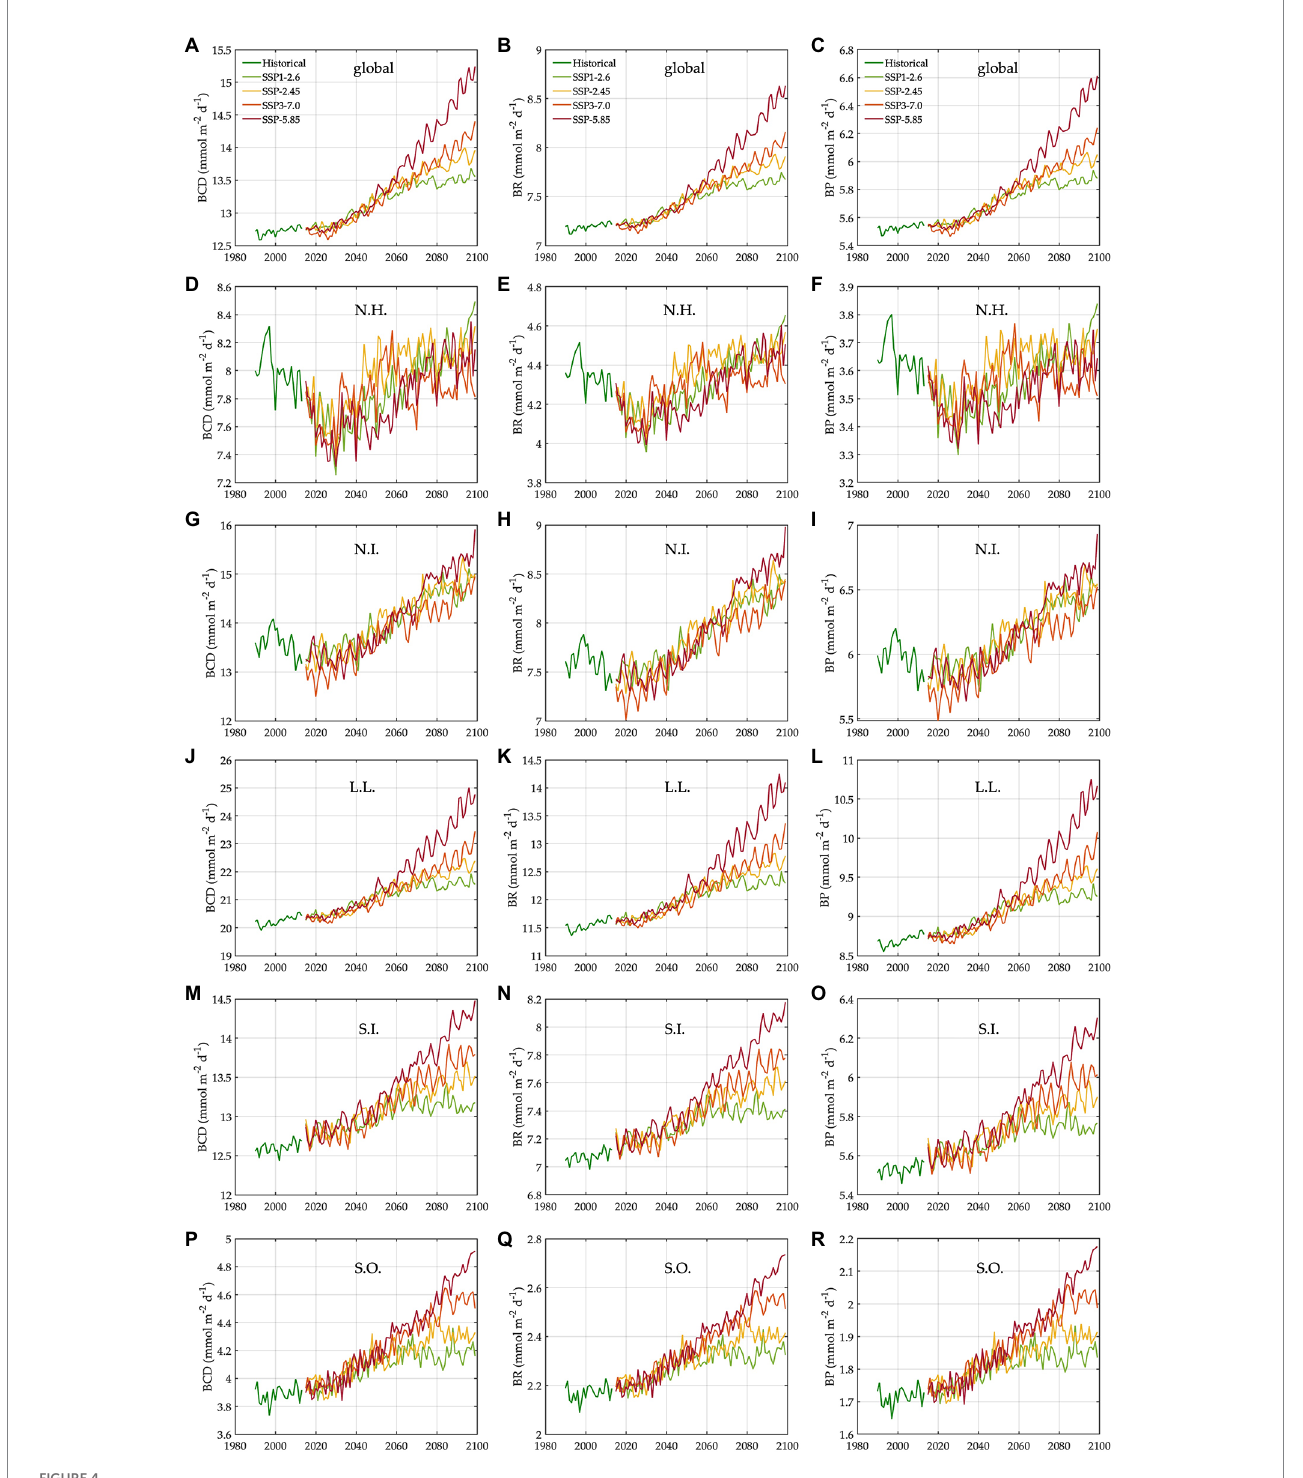
FIGURE 4 Trends in bacterial carbon rates under different climate change scenarios. N.H.: northern high latitudes, N.I.: northern intermediates, L.L.: low latitudes, S.I.: southern intermediates, and S.O.: Southern Ocean. The trends (1990–2099) in bacterial carbon demand in the global ocean (A) , N.H. (D) , N.I. (G) , L.L. (J) , S.I. (M) , and S.O. (P) . The trends (1990–2099) in bacterial respiration in the global ocean (B) , N.H. (E) , N.I. (H) , L.L. (K) , S.I. (N) , and S.O. (Q) . The trends (1990– 2099) in bacterial production in the global ocean (C) , N.H. (F) , N.I. (I) , L.L. (L) , S.I. (O) , and S.O. (R)